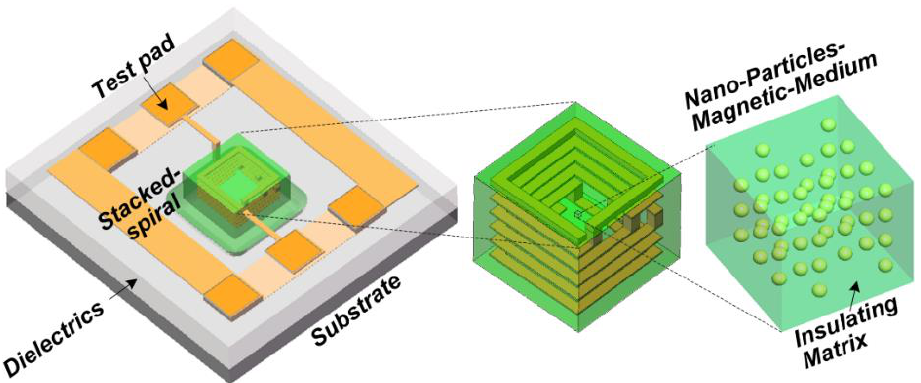
Figure 4. A 6-Al-layer stacked spiral inductor filled with nanomagnetic particles in a CMOS [22].